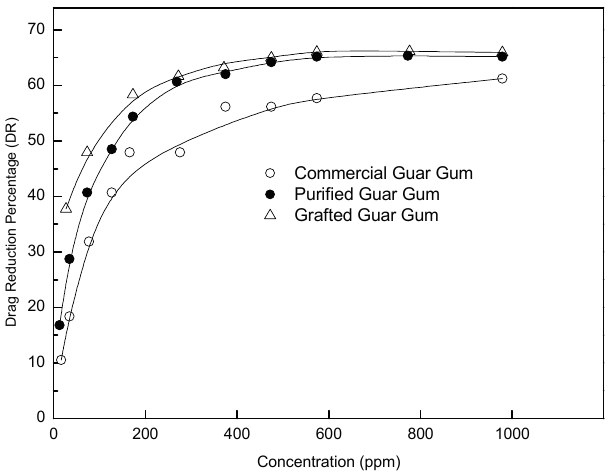
Figure 4. % DR versus concentration of poly(AM- co -AA) copolymer at 1980 rpm (Reprinted from [55]).